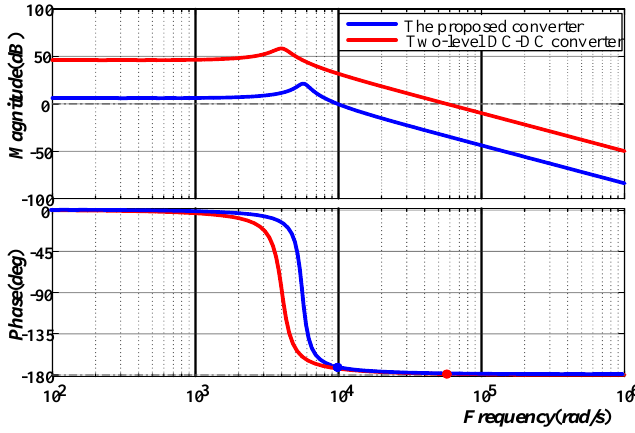
Figure 10. Bode diagram of the open-loop system.